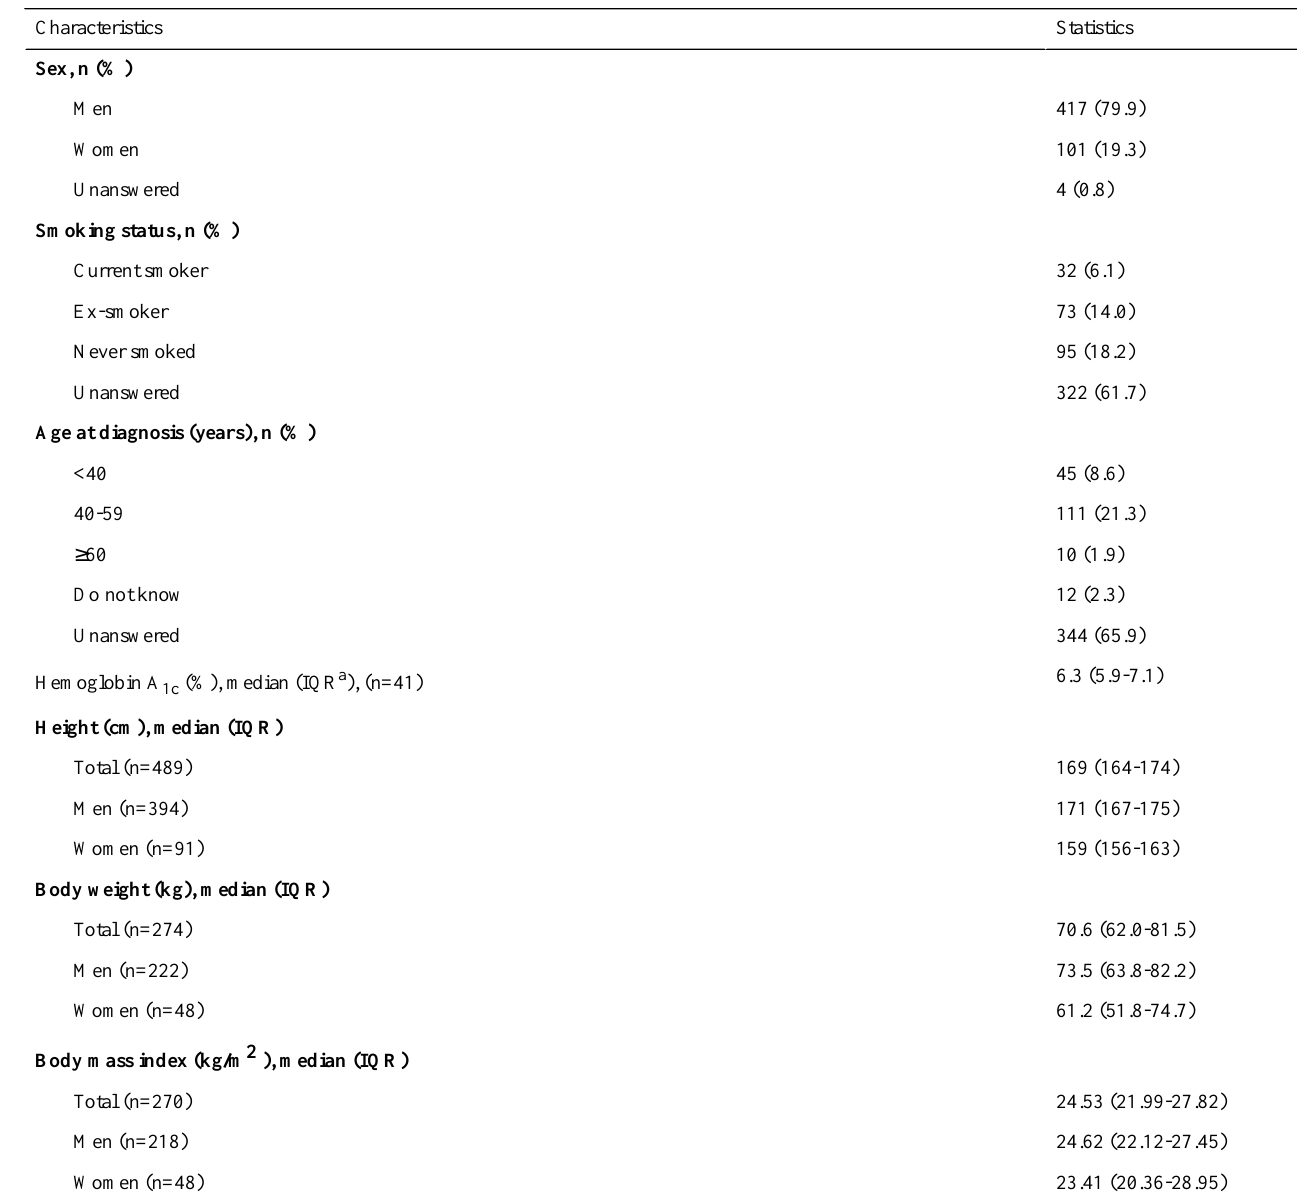
Table 1. Demographics of participants in this study (N=522).